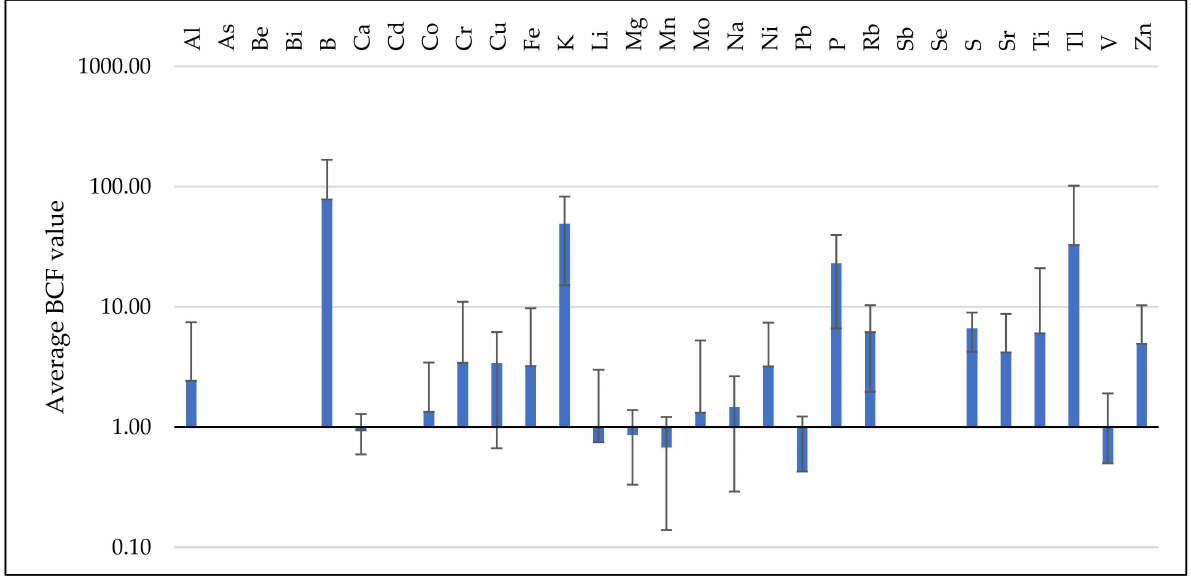
Figure 5. Average values of BCFs, and their corresponding standard deviations, obtained from the available